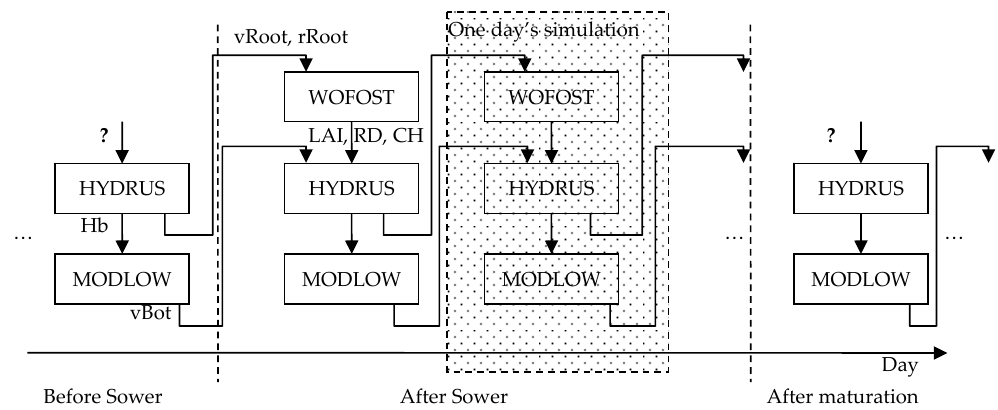
Figure 2. The process of the integrated model’s simulation.